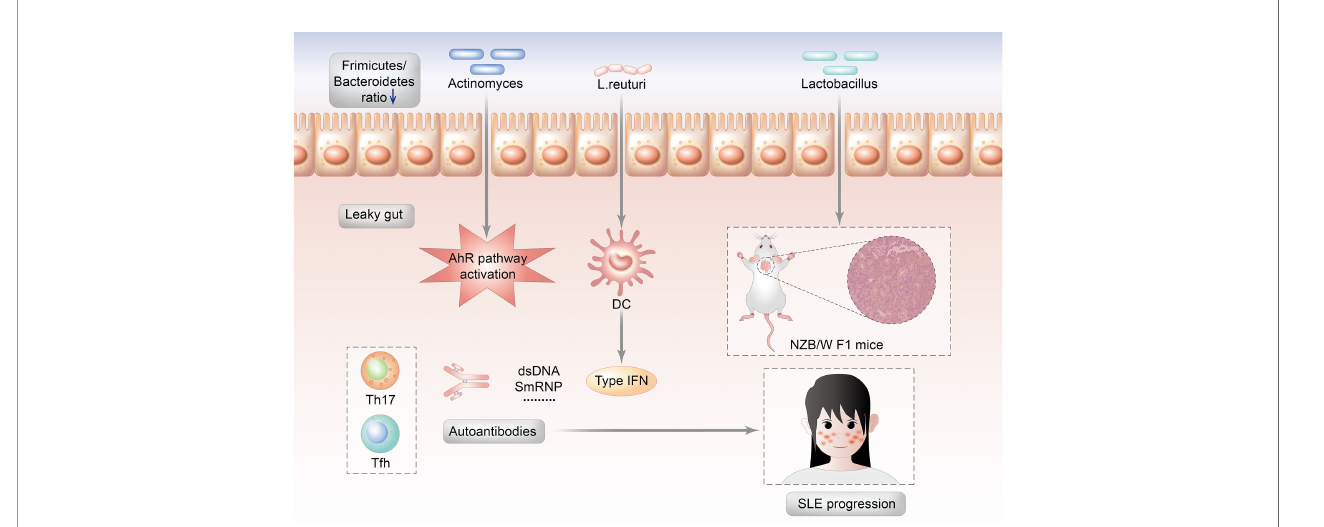
FIGURE 2 | Potential mechanisms by which the Lactobacillus triggers the autoimmunity of